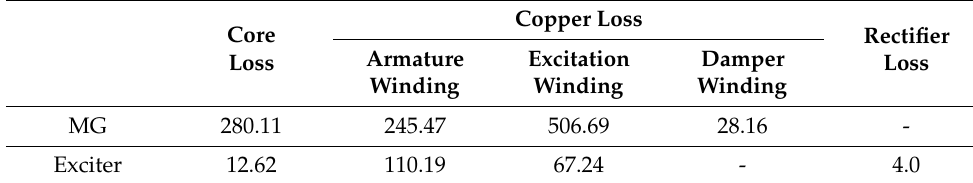
Table 5. BSG loss data (unit: W).